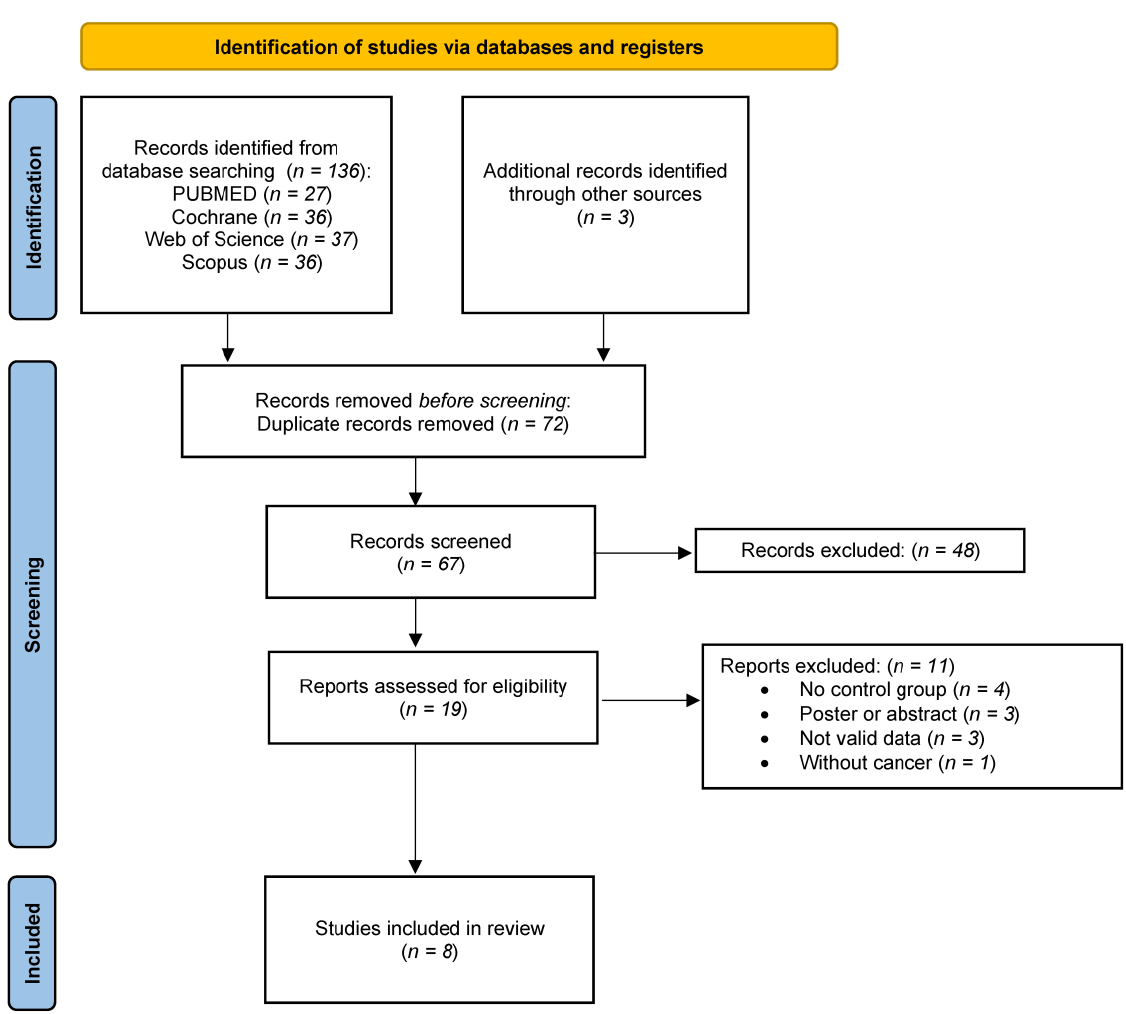
Figure 1. Flow diagram of the systematic review and the literature search results of the systematic review and meta-analysis.